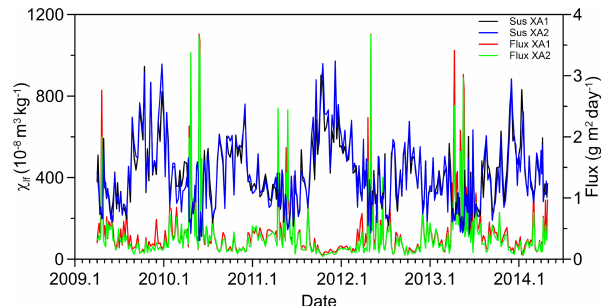
Figure 6. Time series of magnetic susceptibility and dust flux of atmospheric dustfall at XA1 and XA2 from 2009 to